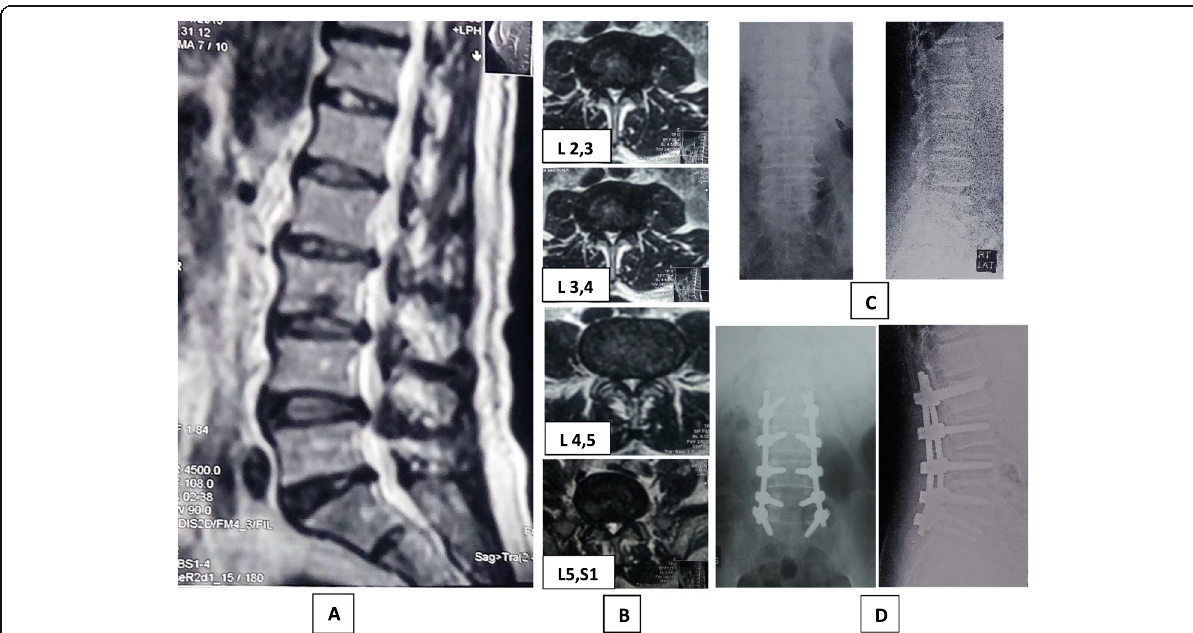
Fig. 1 Seventy-three-year-old male patient, diabetic and had ischemic heart disease presented with low back pain for 3 years that increased in last year, with bilateral lower limb neurogenic claudication and radiculopathy who failed conservative treatment and thus indicated for surgery. He underwent 5 levels of decompression and instrumented fusion. He had no intra- or postoperative complications or disturbed comorbidity. He had improved VAS score from 7 to 1 and ODI from 53 to 6. a , b MRI T2WI sagittal and axial views through L2,3 to L5, S1 showing severe LCS and foraminal stenosis. c Preoperative X-ray, AP and lateral views. d Postoperative X-ray, AP and lateral